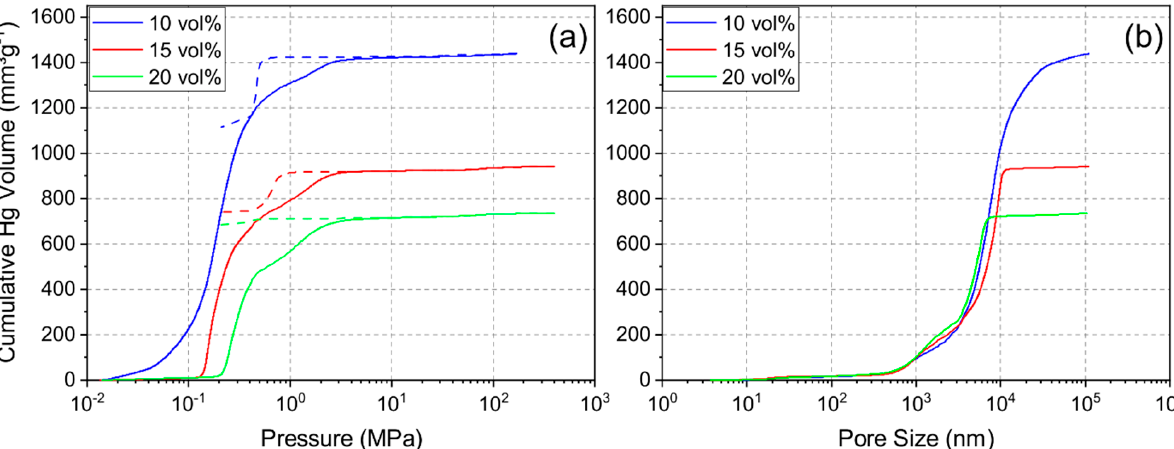
Figure 4. Intrusion and extrusion (dashed line) curves ( a ) and cumulative pore size distributions (intrusion) ( b ) for mercury porosimetry for samples 10Y, 15Y, and 20Y.